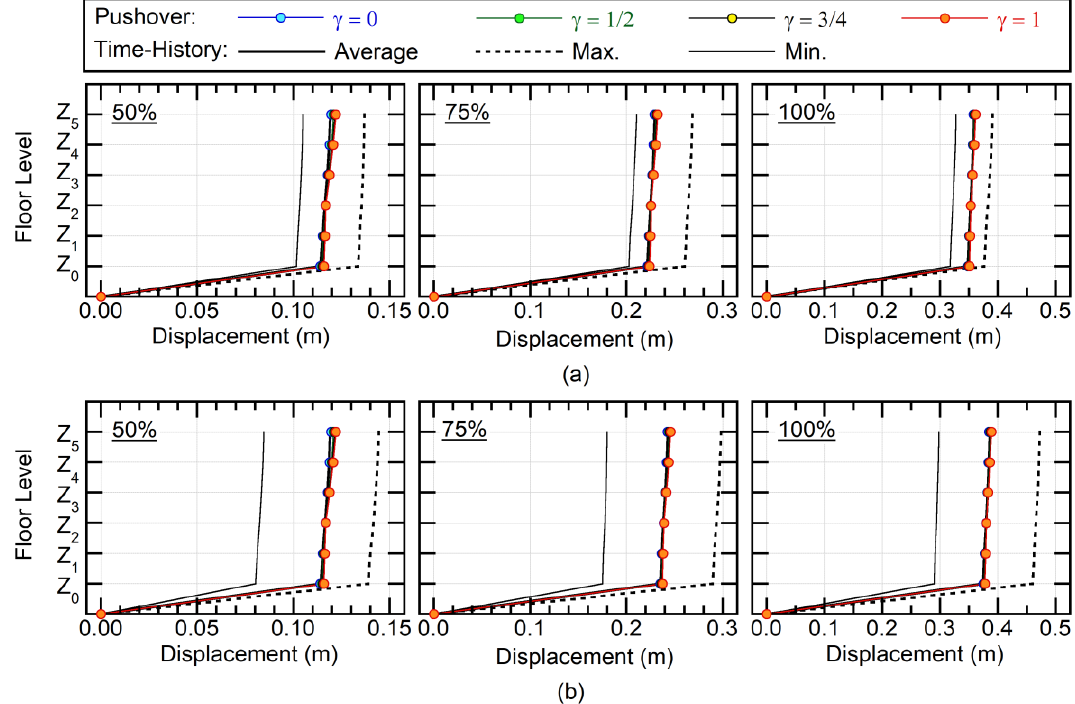
Figure 17. Comparison of the peak relative displacement of Model-05: ( a ) Art-S series and ( b ) Art-L series.